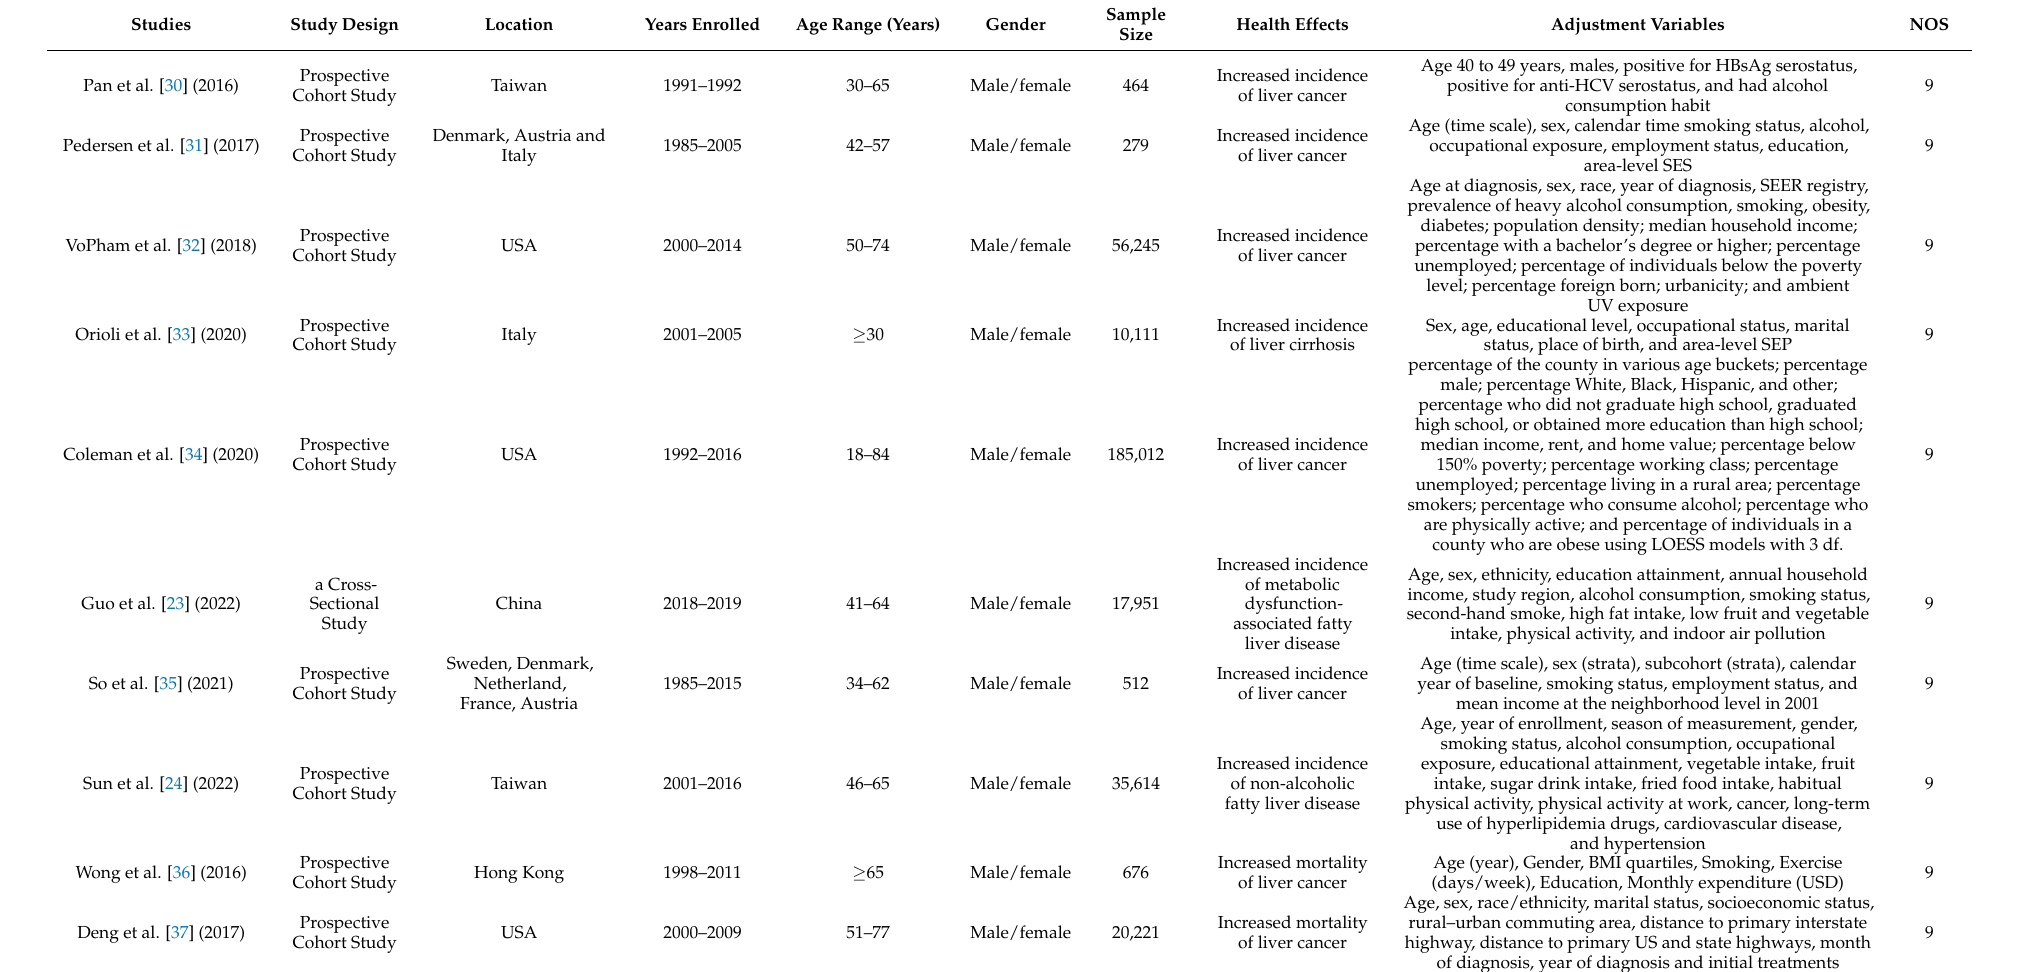
Table 1. General characteristics of included